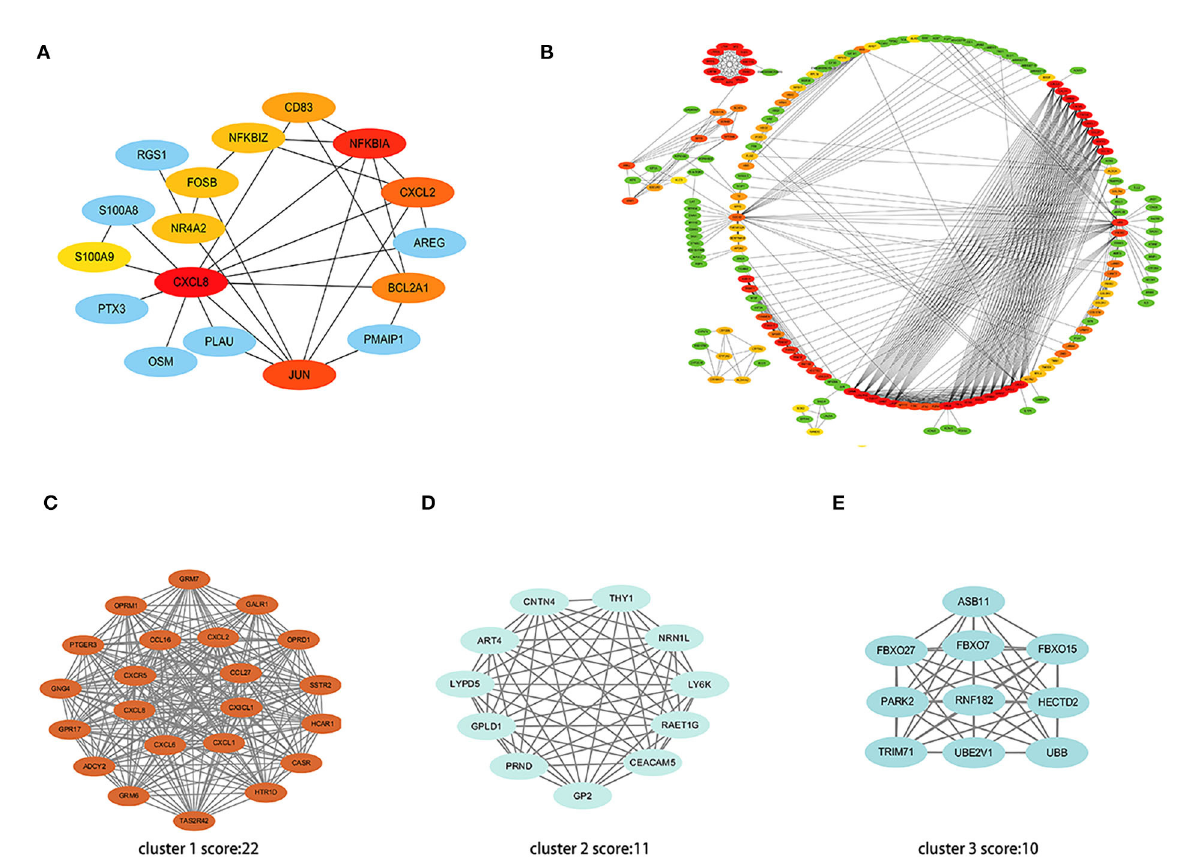
FIGURE6 PPI network of DEGs. (A) The interaction network shows the important genes and their interactions among 35 co-expressed DEGs. (B) The interaction network shows the important genes and their interactions in the high throughput sequencing dataset. (C–E) Three most significant clusters of the high throughput sequencing dataset. Each node represents a protein, while each edge represents one protein-protein